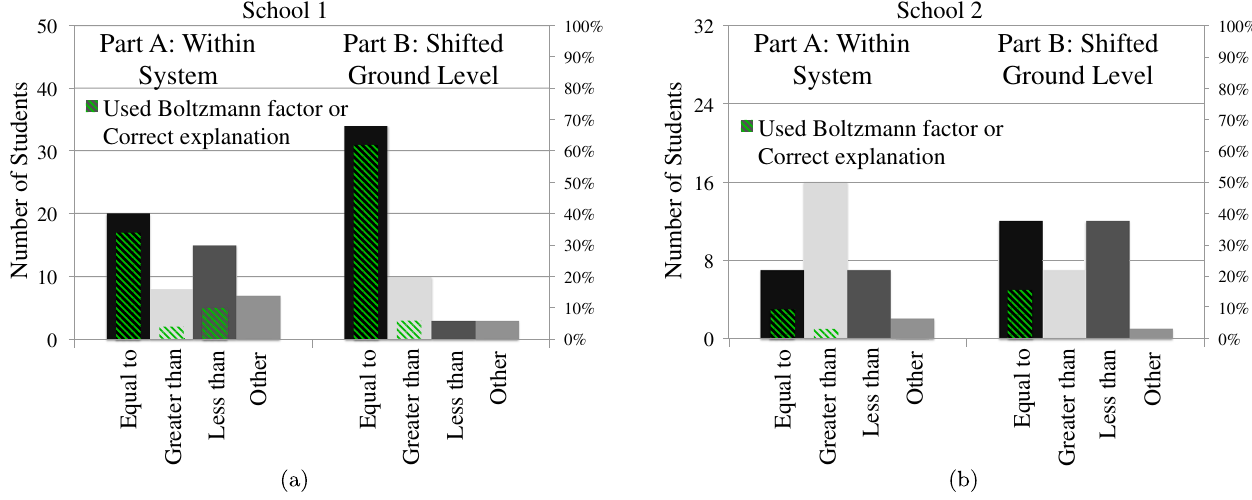
FIG. 3. PRQ pretutorial results. (a) School 1, after lecture instruction on the Boltzmann factor over seven years ( N ¼ 50 ); (b) school 2, before any instruction on the Boltzmann factor in one year ( N ¼ 32 ). The green diagonal stripes indicate the students who used the Boltzmann factor or stated that the energy of the ground state was irrelevant (in part B) to obtain their chosen answers. Students in the “ Other ” column often provided no explicit answer or stated that there was not enough information to determine the answer. Only 24 students from school 1 and four students from school 2 used the Boltzmann factor on both parts.